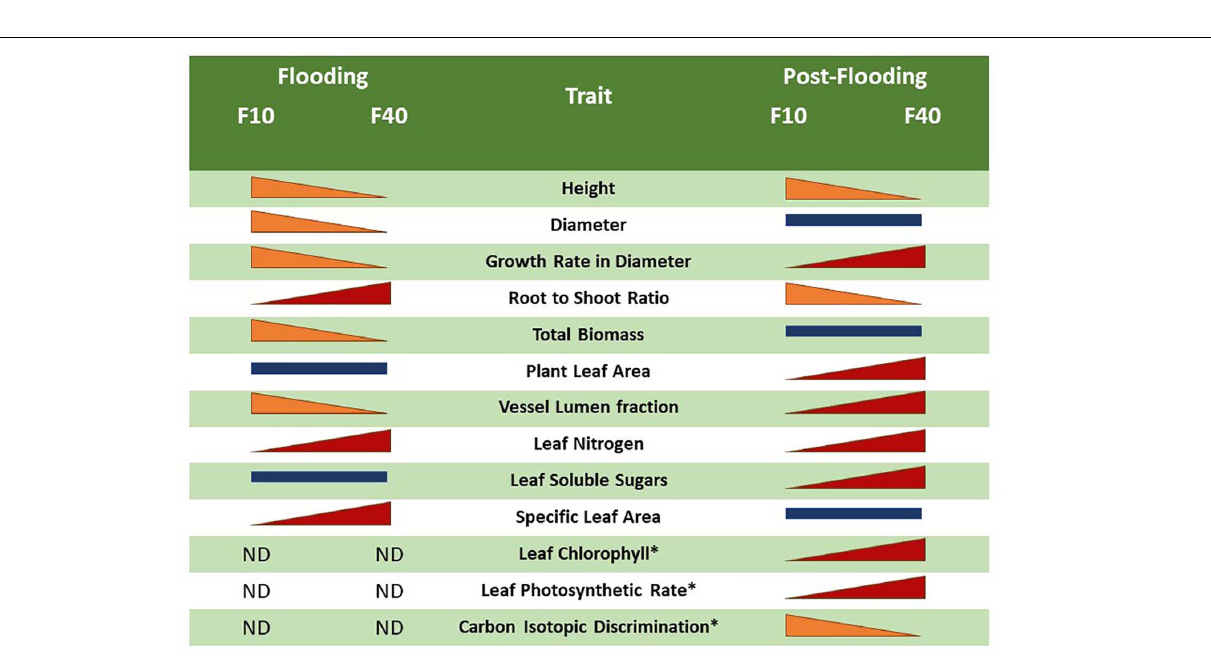
Frontiers in Plant Science |